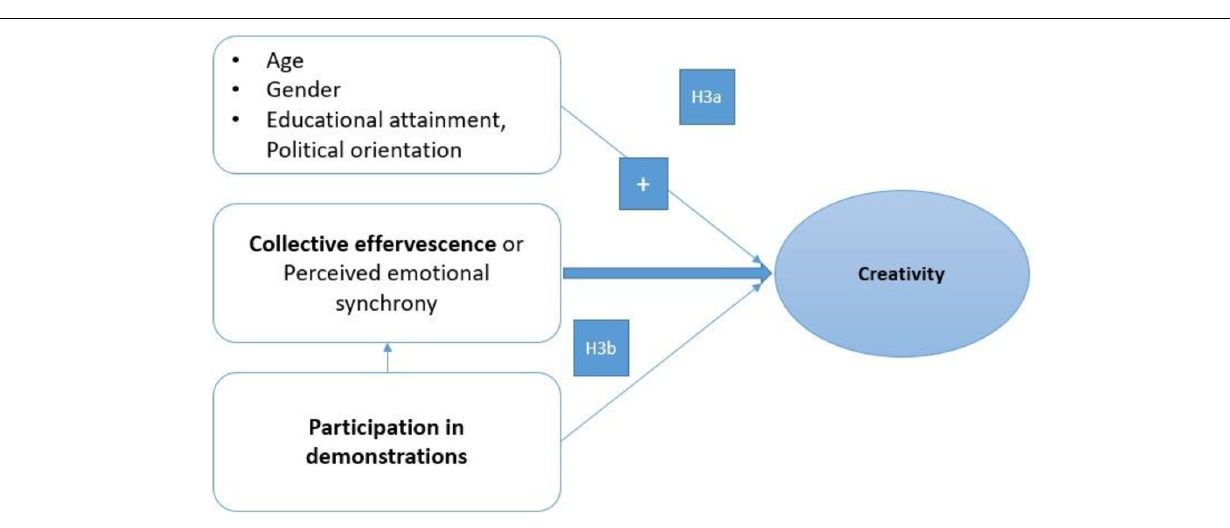
FIGURE 3 | Predictors of creative